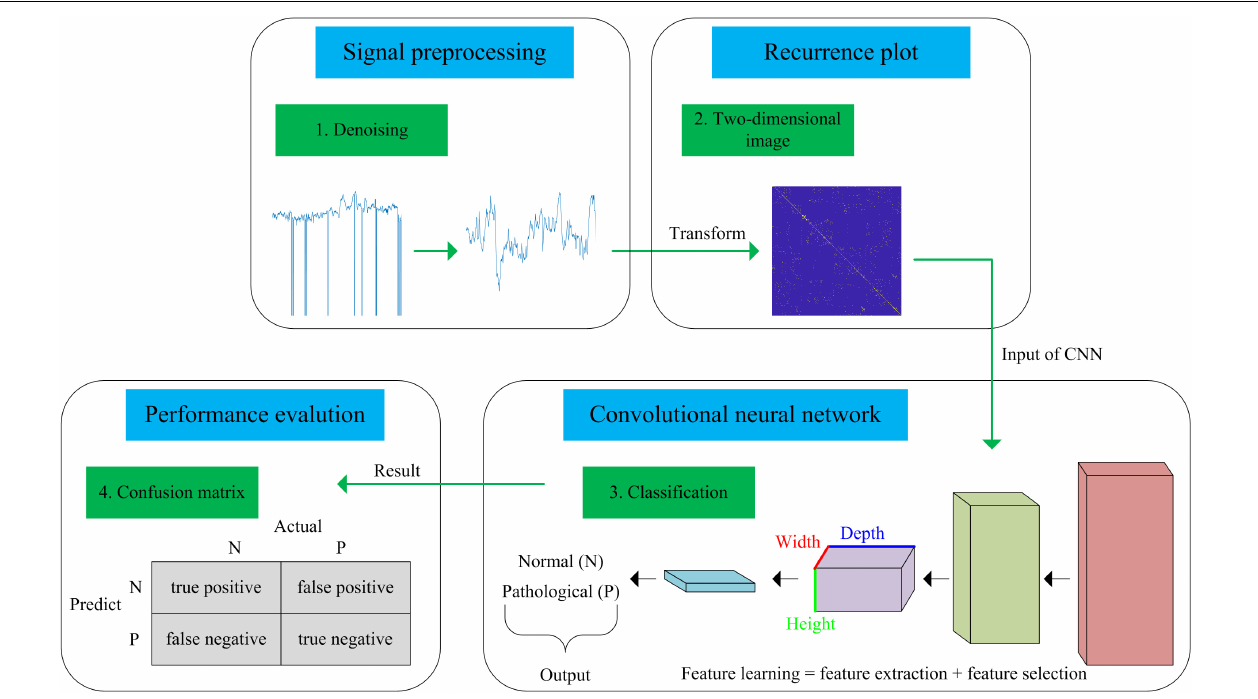
FIGURE 1 | Flow chart of the proposed computer-aided diagnosis (CAD) system incorporating a recurrence plot (RP) and convolutional neural network (CNN).